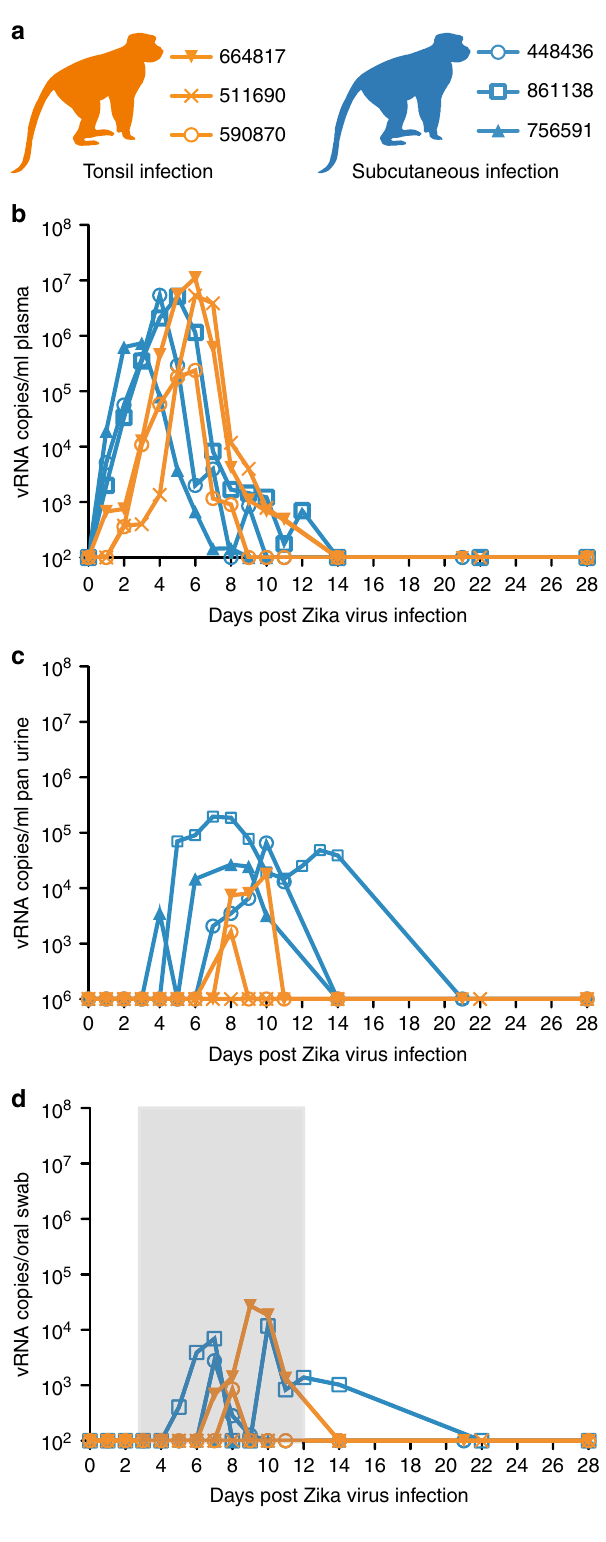
Fig. 2 Longitudinal detection of ZIKV RNA in plasma, urine and oral swabs in subcutaneously infected animals ( blue ) or animals inoculated directly to the tonsils ( orange ). a Legend for graphs represented in parts b – d . Orange lines represent animals infected via the tonsils and blue lines represent animals infected via subcutaneous injection. b ZIKV RNA copies per ml of peripheral blood plasma. c ZIKV RNA copies per ml of passively collected urine from pans. d ZIKV RNA copies per oral swab. The gray box indicates the time frame in which saliva or an oral swab sample from saliva donor animals was used to challenge recipient animals. The y axis starts at the limit of quanti fi cation of the qRT-PCR assay (100 vRNA copies per